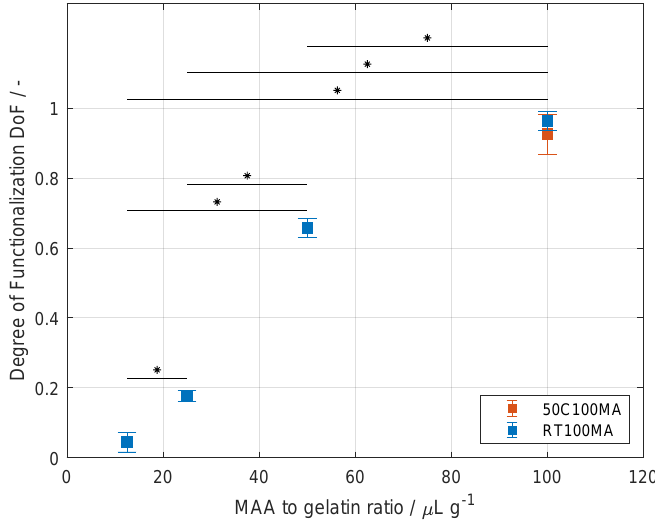
Figure 3. Degree of functionalization (DoF) of produced gelatin methacryloyl (GelMA) batches the DoF was determined by the TNBS method [19]. No difference was found between samples produced a room temperature and samples produced at 50 °C at 100 µLg − 1 . The DoF increased significantly with increasing the methacrylic anhydride (MAA)-to-gelatin ratio. Asterisks denote a significant difference between samples ( p <